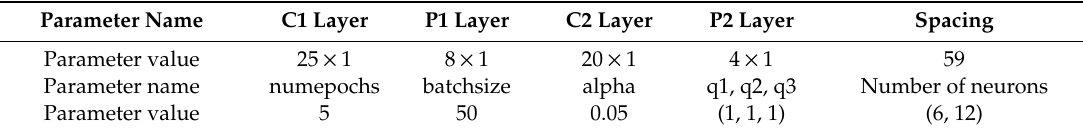
Table 3. The MDI-CNN parameters; numepochs denotes the number of iterations of the model, batchsize denotes the number of samples processed per batch by the model during the batch training, and alpha denotes the learning rate.